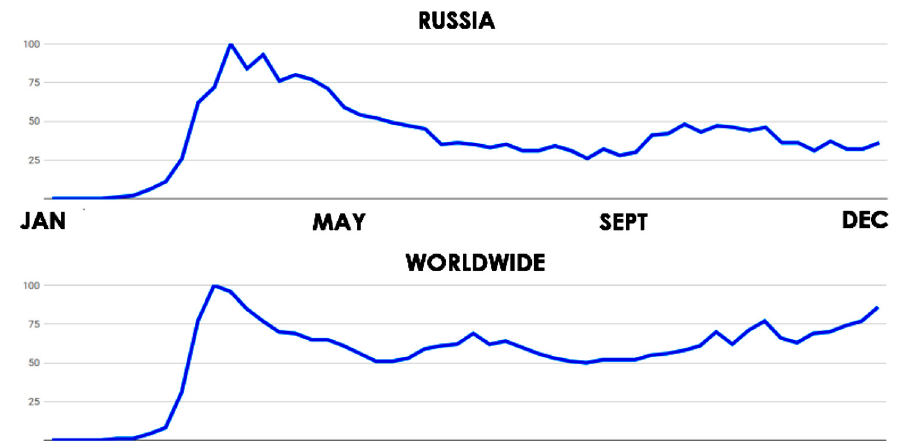
Figure 2. Search trend by keyword «COVID». Worldwide data. Source: compiled by the authors according to Google Trends